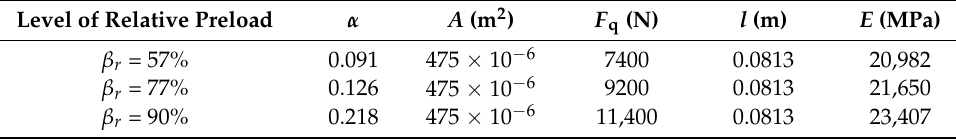
Table 3. Parameters of equivalent model under different levels of bolt preload.